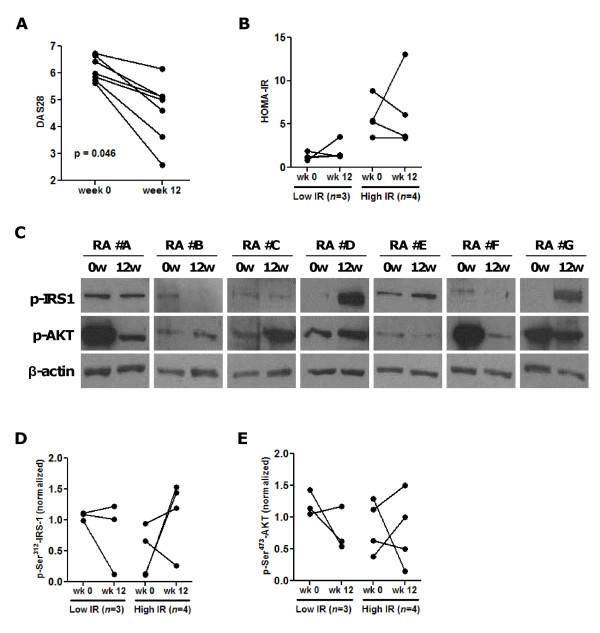
Variable effect of CTLA4.Ig (abatacept) treatment on insulin receptor substrate (IRS)-1 and AKT phosphorylation in patients with rheumatoid arthritis (RA). (A) Improvement in disease activity in RA patients (n = 7) following treatment with abatacept for 12 weeks, from median disease activity score in 28 joints (DAS28) 5.9 to 4.8 (P = 0.046, Wilcoxon signed ranks test). (B) Treatment with abatacept had variable effects on the Homeostasis Model Assessment for insulin resistance (HOMA-IR) in RA patients with low or high baseline insulin resistance. (C) Protein extracts from periperhal blood mononuclear cells of the RA patients were analyzed by western blotting for the Ser312 and Ser473- phosphorylated forms of insulin resistance substrate (IRS)-1 and AKT, respectively, at baseline and after 12 weeks treatment with abatacept. (D) Quantitative analysis of p-Ser321 IRS-1 normalized to β-actin expression showed no significant change following treatment with abatacept. (E) Variable trend in p-AKT levels from baseline to week 12 of treatment with abatacept in RA patients with low or high baseline insulin resistance.